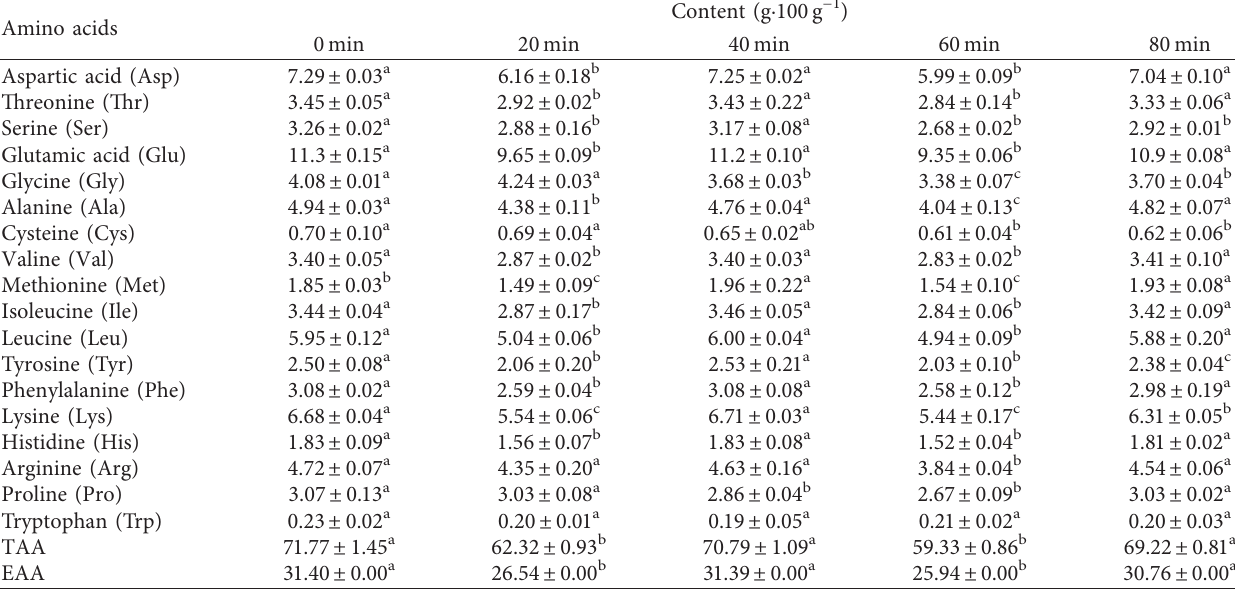
Table 3: Amino acid profiles (g · 100g − 1 ) of giant salamander jerky as affected by roasting time. Amino